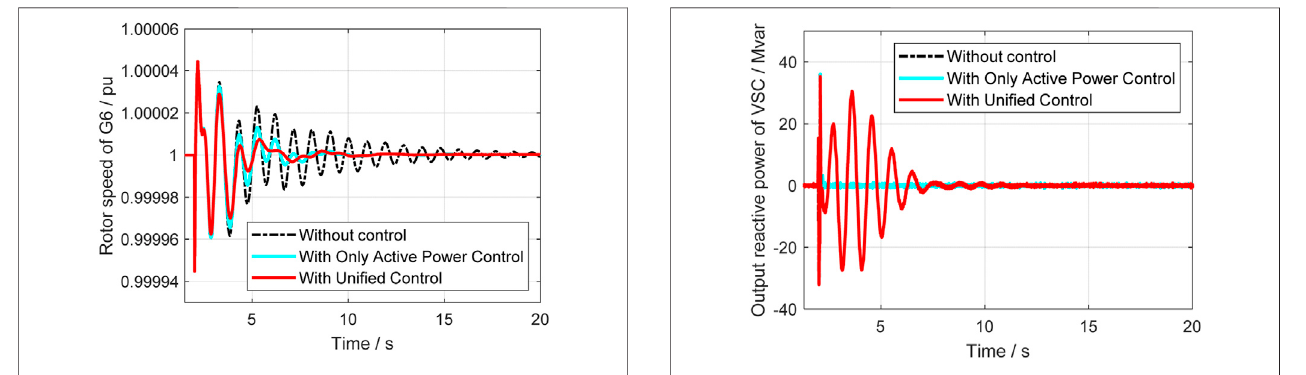
FIGURE 20 | Rotor speeds of G6 with different schemes.